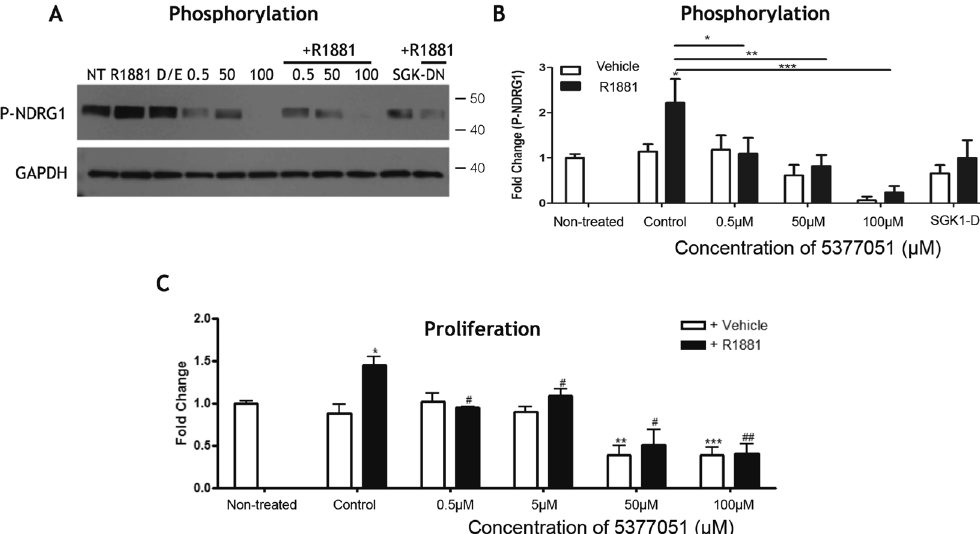
Figure 3. Validation of lead SGK1 inhibitor compound in a prostate cancer cell line. ( A ) Western blot demonstrating inhibition of SGK1 by compound 5377051 blocked the phosphorylation of SGK1 target NDRG-1 in response to the androgen analog R1881. ( B ) Quantification of NDRG-1 phorsphorylation. ( C ) 5377051 inhibited the proliferation of LNCaP prostate cancer cell line induced by the androgen analog